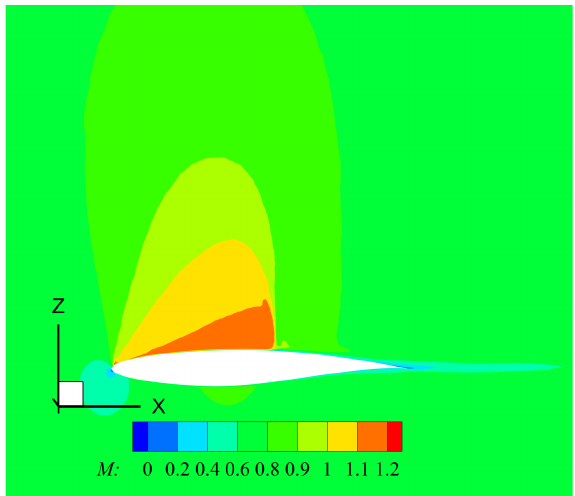
Figure 5. Iso-contours of Mach number (Wilcox k - ω